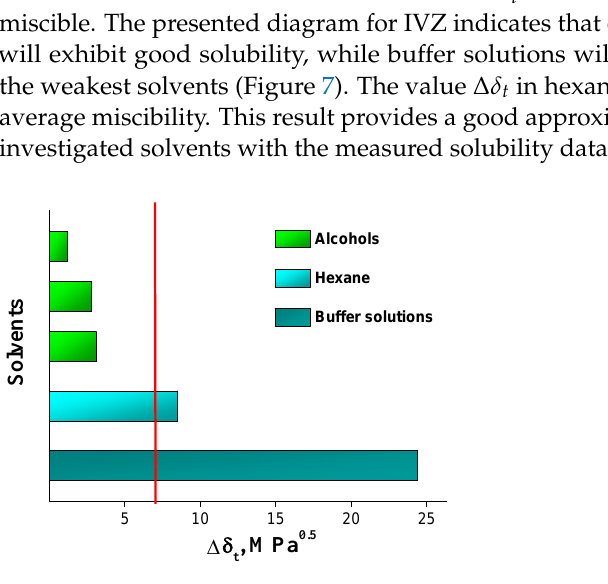
Figure 7. Differences in the total HSPs of IVZ with solvents. The red line is an indicator of misci- bility.